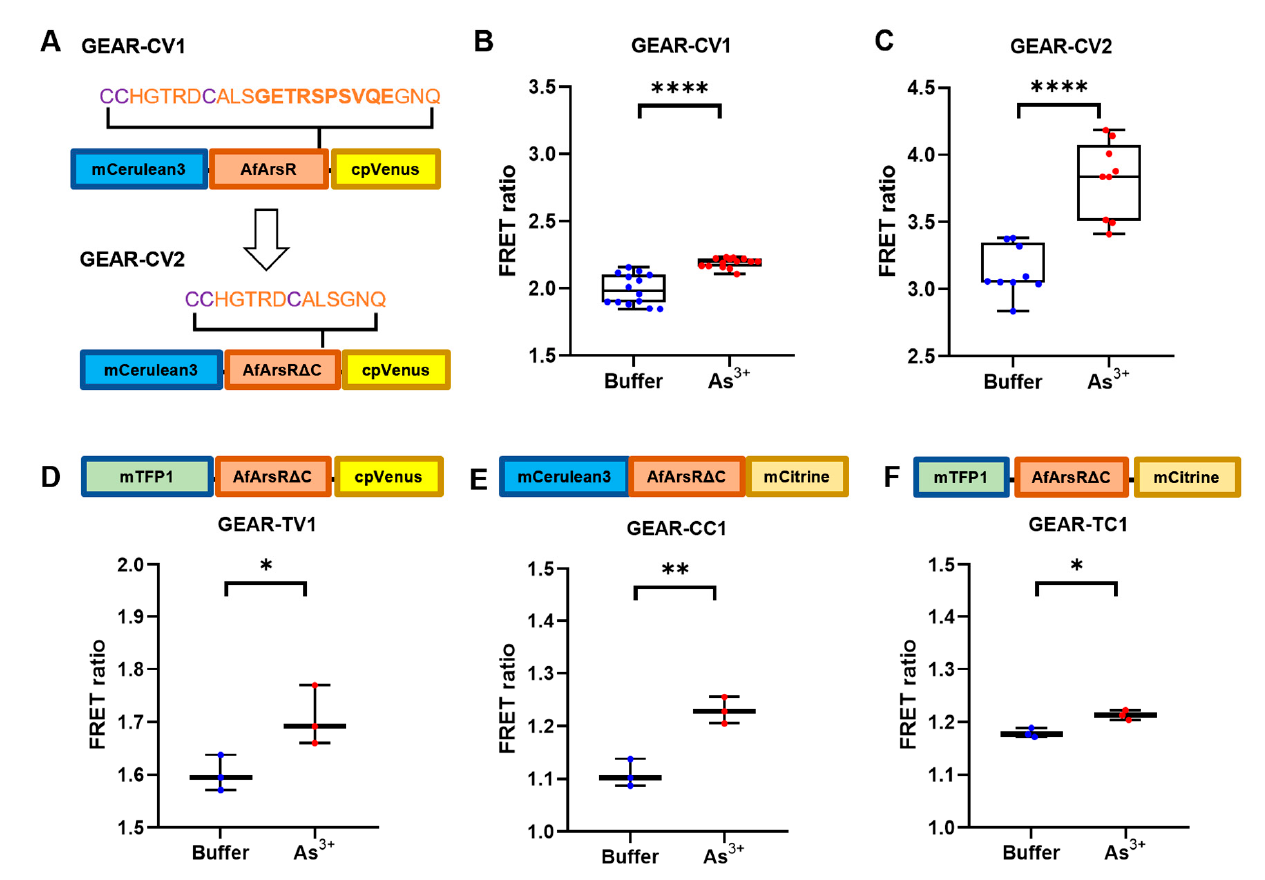
Figure 3. Optimization of GEAR-CV1 with structure-guided deletion and FRET donor/acceptor alteration. ( A ) Deletion of AfArsR C-terminus residue resulting in GEAR-CV2 with improved FRET ratio change. ( B ) FRET ratio of GEAR-CV1, in Tris-buffered saline without (blue) and with (red) 1 mM As 3+ . ( C ) FRET ratio of GEAR-CV2, in Tris-buffered saline without (blue) and with (red) 1 mM As 3+ . ( D – F ) FRET-based GEAR variants with alternative FP donor and acceptor. FRET ratios of GEAR-TV1 (mTFP1/cpVenus) ( D ), GEAR-CC1 (mCerulean3/mCitrine) ( E ), and GEAR-TC1 (mTFP1/mCitrine) ( F ), in Tris-buffered saline without (blue) and with (red) 1 mM As 3+ . Significant differences between pairs are indicated as **** ( p < 0.0001), ** ( p < 0.01), and * ( p < 0.05).